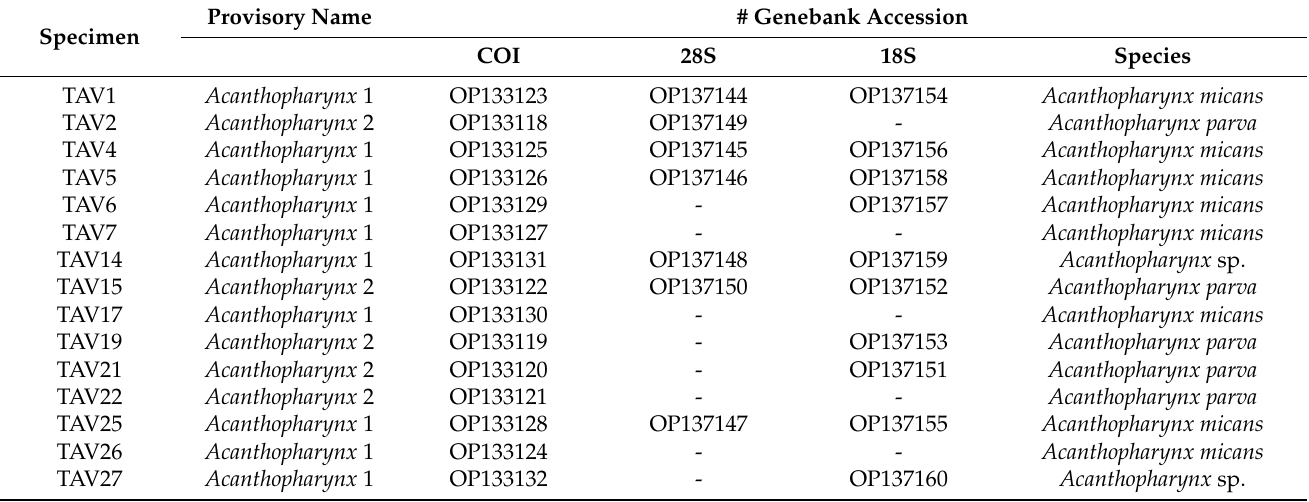
Table 2. The Genebank accession numbers of sequences obtained during the current